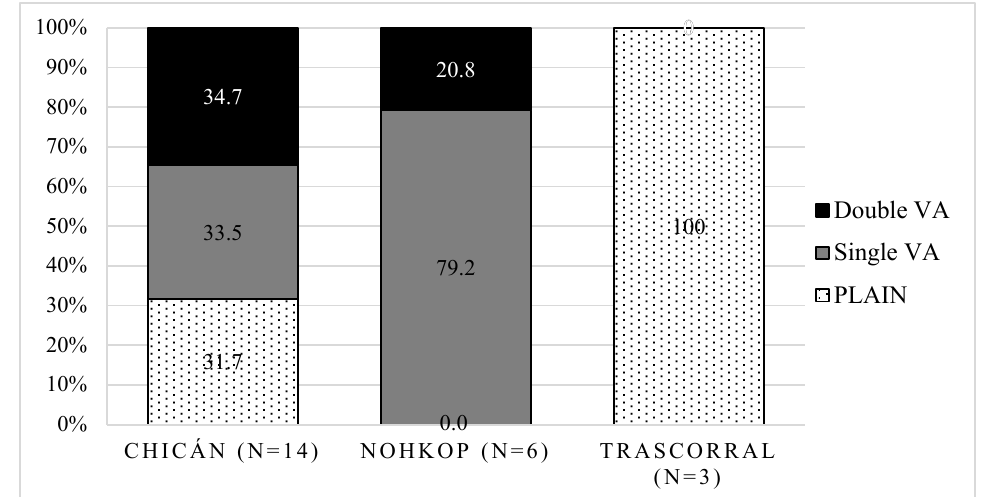
Figure 8. Results of the strategies used by the participants in the task separated by community (in percentages).